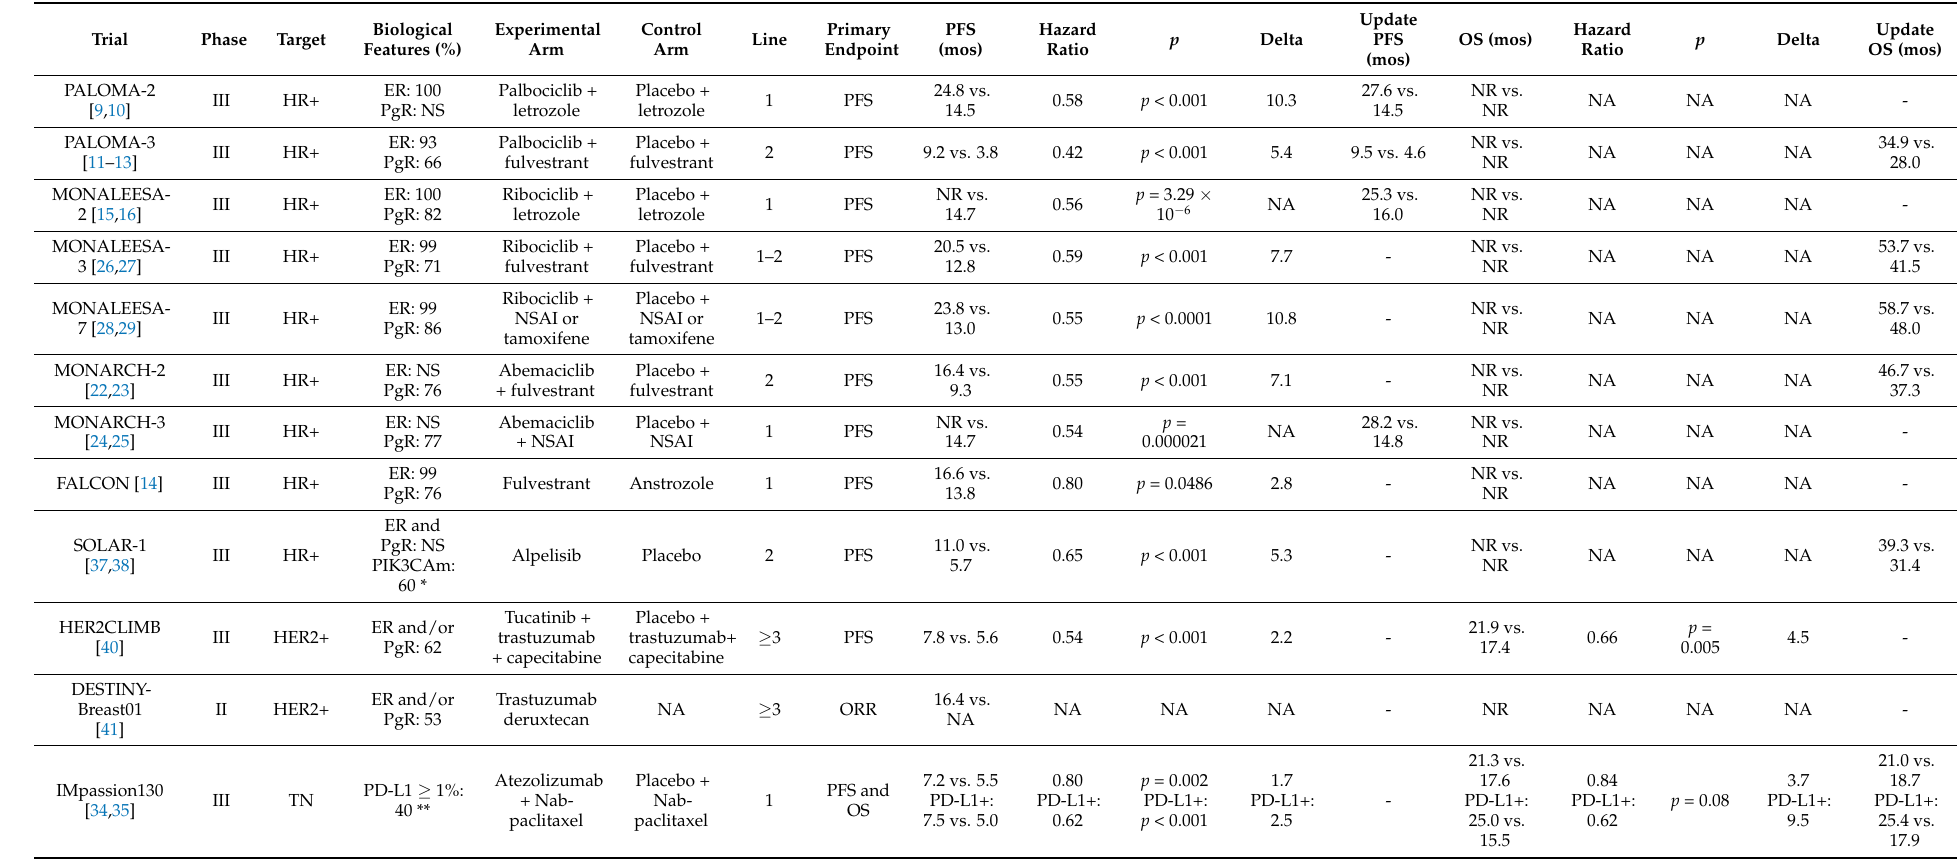
Table 3. Results of clinical trials (first analysis and update) leading to the approval for the treatment of metastatic breast